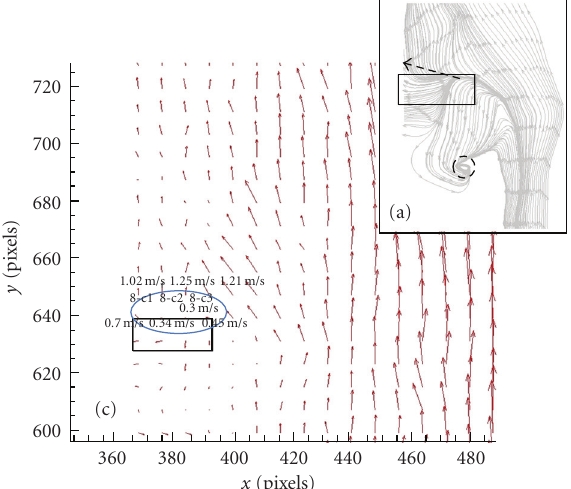
Figure 8: (a) Streamlines passing through the left flame edge of case 5. (c) Velocity variation at the flame edge of case 5. The points’ velocities in the rectangle are 0.7m/s, 0.34 m/s, 0.30 m/s, 0.45 m/s, 0.71 m/s, 0.99 m/s, 1.0 m/s, and 0.8 m/s (ordered by left to right, top down). The velocities of 8-c1, 8-c2, and 8-c3 points are 1.02 m/s, 1.25m/s, and 1.21